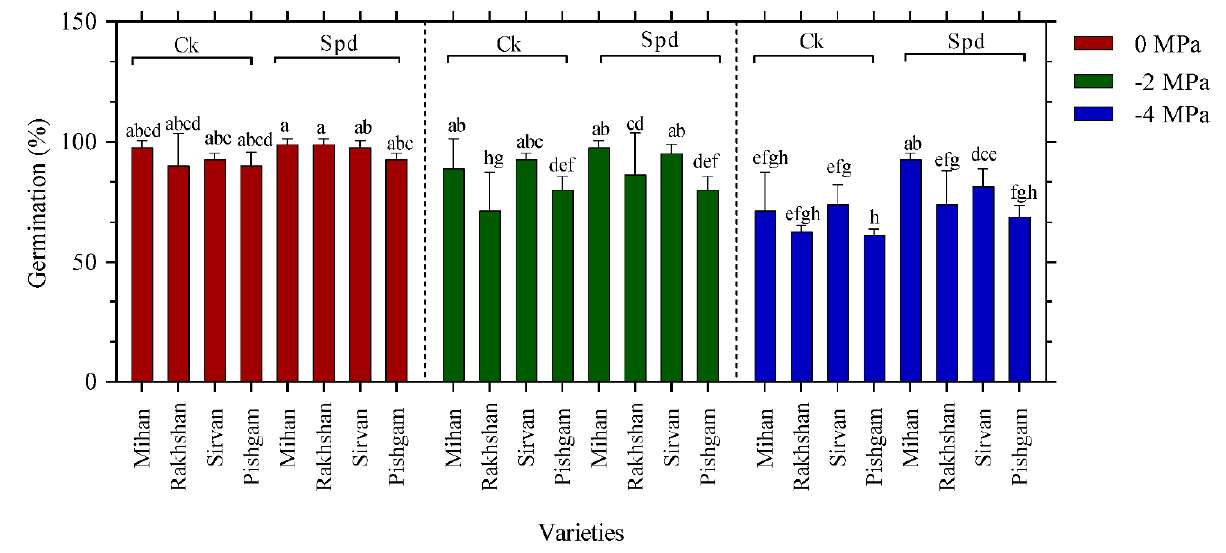
Figure 5. Effect of spermidine (Spd) on germination percentage of four wheat varieties under drought stress with three levels of PEG 6000 osmotic potential (−2, −4 MPa and 0 using distilled water as control). Ck = distilled water. Different letters indicate statistically significant differences across all three levels of PEG 6000 at p < 0.05 level using LSD’s test.